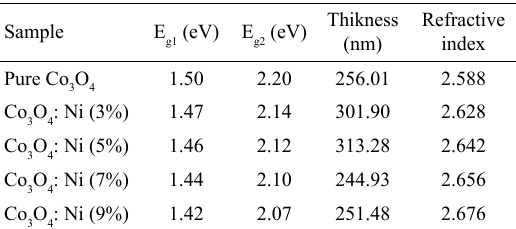
Figure 4. Plot of ( αhν ) 2 versus hν of pure and Ni-doped Co Table 2. Band gap energy, thikness and refractive index of pure and Ni-doped Co O 3 4